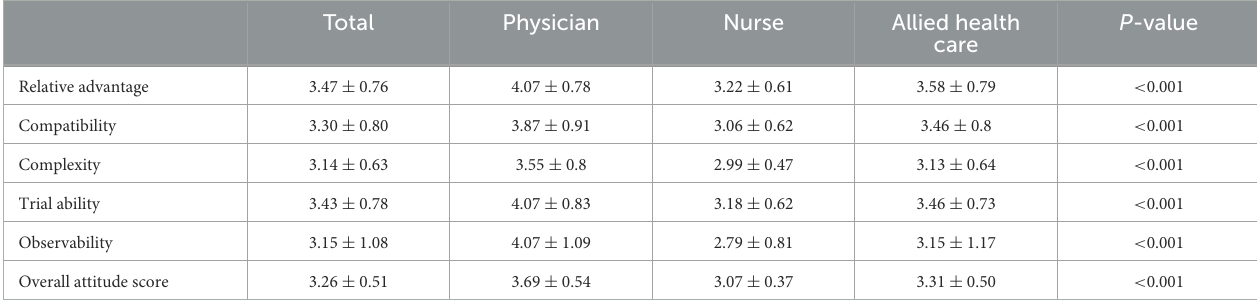
TABLE 3 Comparative analysis of dimension scores among health care professionals. Total Physician